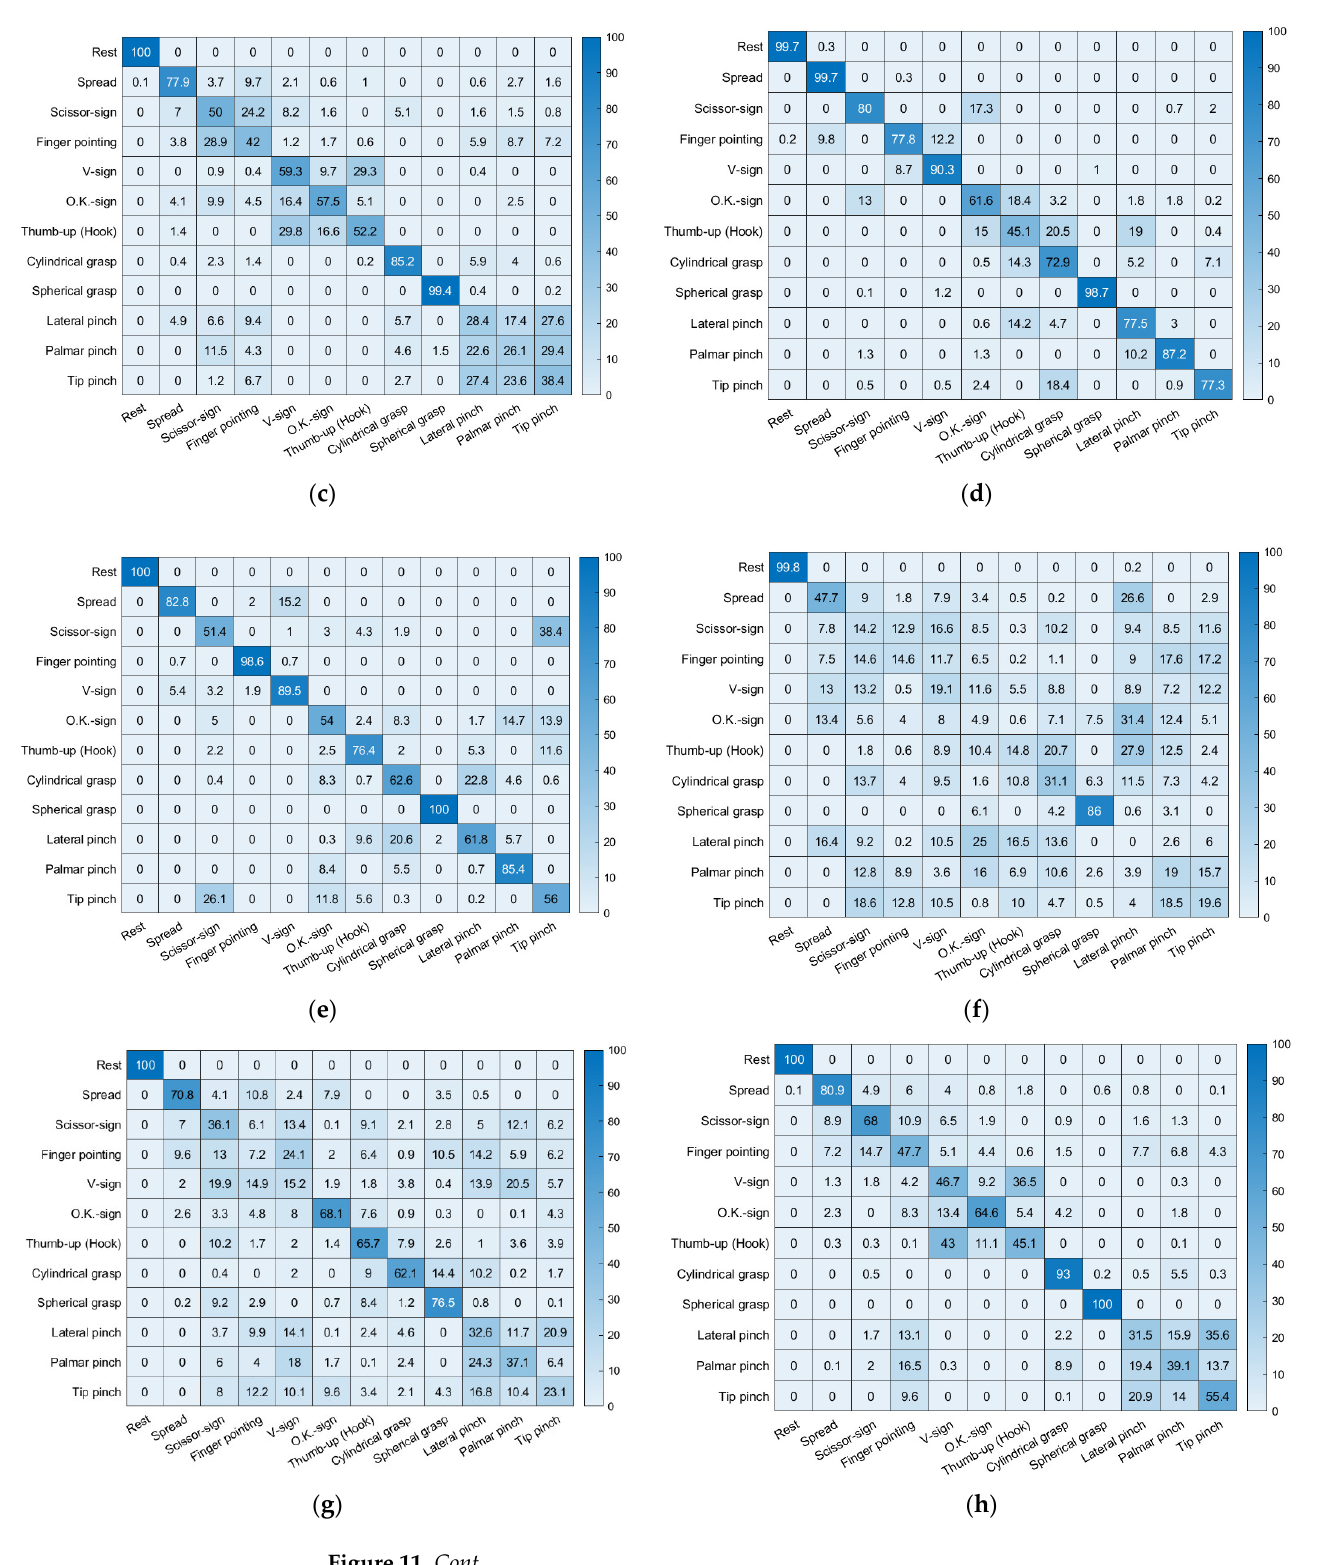
( j ) Figure 11. Confusion matrixes for the forearm amputee: ( a – e ) Day 1 to Day 5 with MAV only, ( f – j ) Day 1 to Day 5 with Hudgins’ set. In the forearm amputee, only the hand postures of rest (MAV: 95.1%, Hudgins’ set: 99.8%) and spherical grasp (MAV: 94.1%, Hudgins’ set: 86.0%) were well-recognized with either feature vector on Day 1, which was the experiment before visual feedback training. The classification accuracies of each hand posture were improved by the visual feedback training, and most of the hand postures were recognized with a classification accuracy of higher than 70.0% on Day 4. In the data from Day 5, the last day of visual feedback training, MAV only showed many misclassifications of scissor sign vs. tip pinch (32.3 ± 6.2%) and cylindrical grasp vs. lateral pinch (21.7 ± 1.1%). Those misclassi- fications remained high with Hudgins’ set (scissor sign vs. tip pinch: 22.3 ± 2.0%, cylin- drical grasp vs. lateral pinch: 11.1 ± 0.8%). 4. Discussion An electric prosthesis can perform some of the functions of a lost limb by using electromechanical motors and structures; it is an essential device for improving the qual- ity of life for amputees [53]. The hand is an especially important body part that is used to perform many gestures in daily life, so amputees who lose a hand need a multiple DoF electric hand prosthesis. Many previous studies have reported the development of vari- ous electric hand prostheses with improved motors or newly designed structures [53–